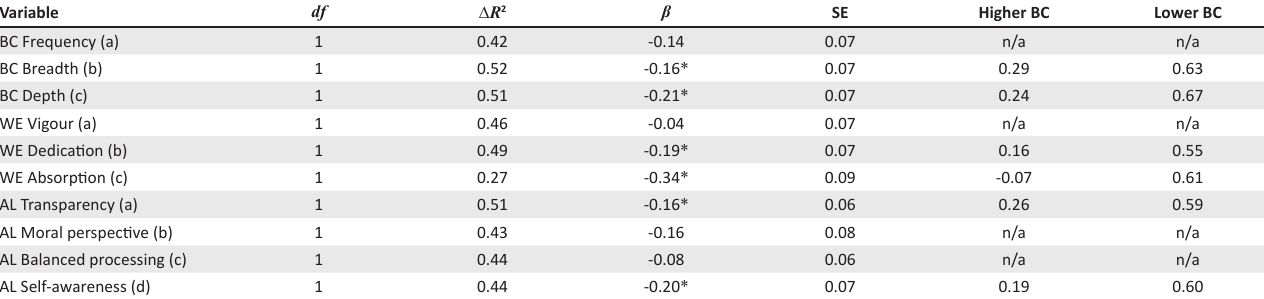
TABLE 3: Results of moderator regression analysis on beneficiary contact’s effect on individual scales of authentic leadership and work engagement. Variable